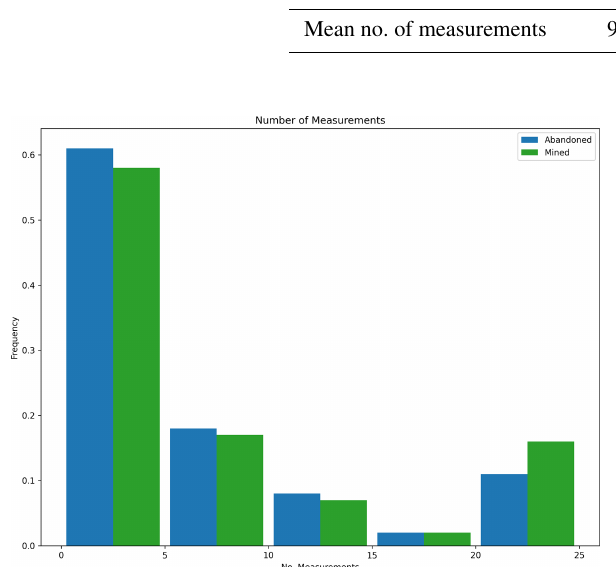
Figure 19. Relative MAE for single mineralization, variable loca- tion. The plot shows the mean relative absolute error after a given number of measurements taken under each tested method. The mean absolute error is shown along with 1 standard error bounds for each trend.